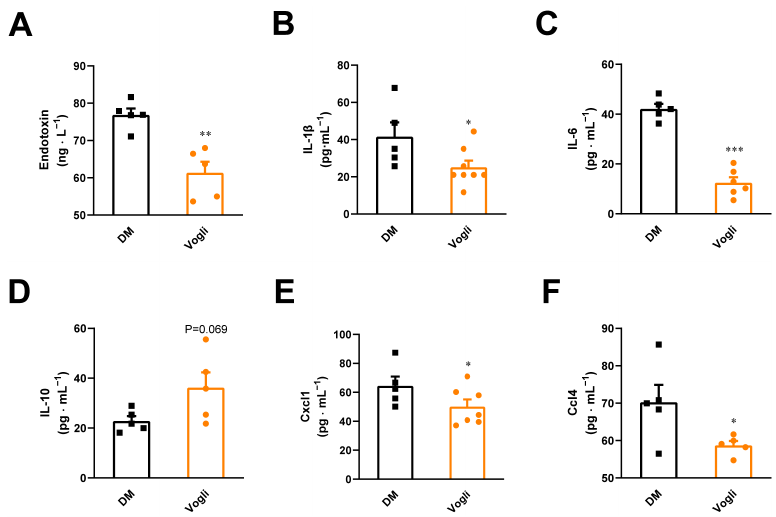
Figure 4. Voglibose improves inflammatory status in KKAy mice. ( A ) Endotoxin, ( B ) IL- 1β, ( C ) IL- 6, ( D ) IL-10, ( E ) Cxcl1, ( F ) Ccl4. Data are expressed as the mean ± SEM and individual data was